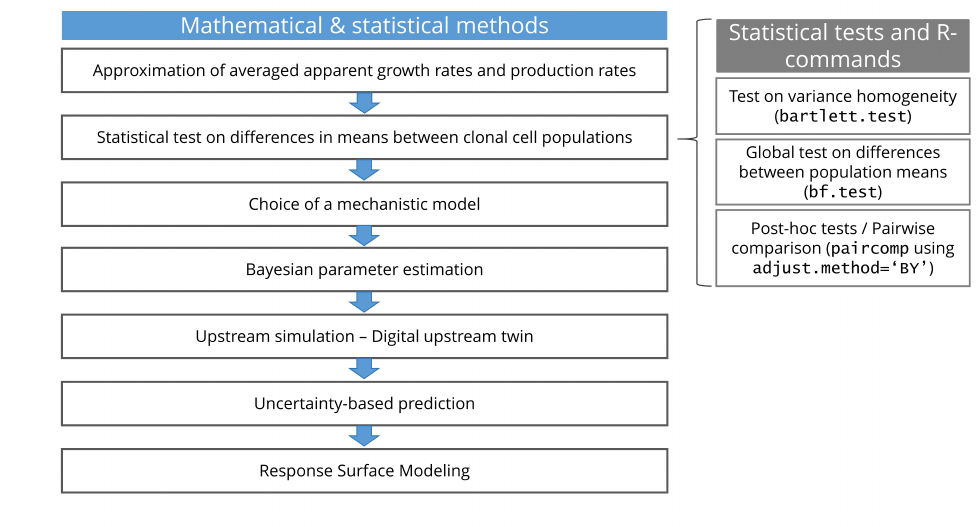
Figure 2. Summary of mathematical, statistical and computational methods applied in the presented study including the applied R-commands for statistical tests.